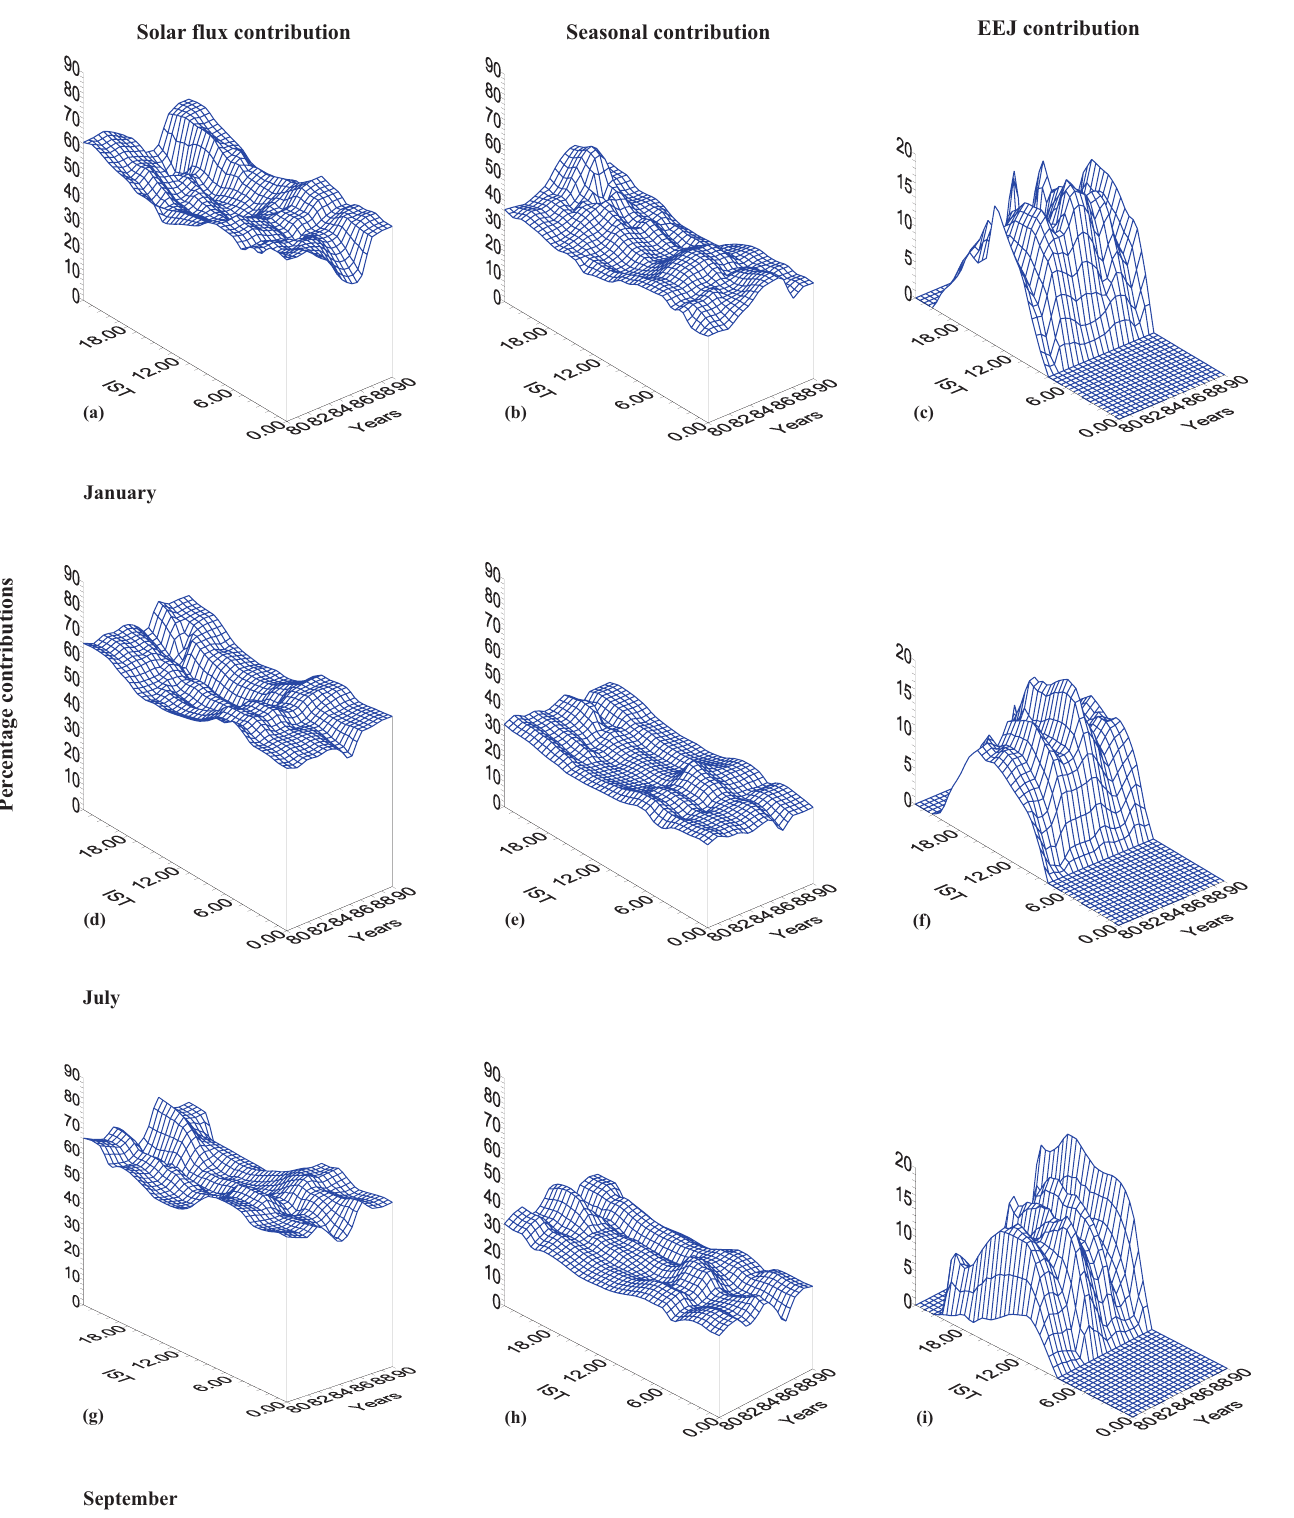
Figure. 8 Fig. 8. Surface plots characterizing solar flux (first column), seasonal (second column) and EEJ contributions (third column) respectively in the estimated TEC values for the period 1980–1990 and for the months of January (upper panel), July (middle panel) and September (bottom panel),